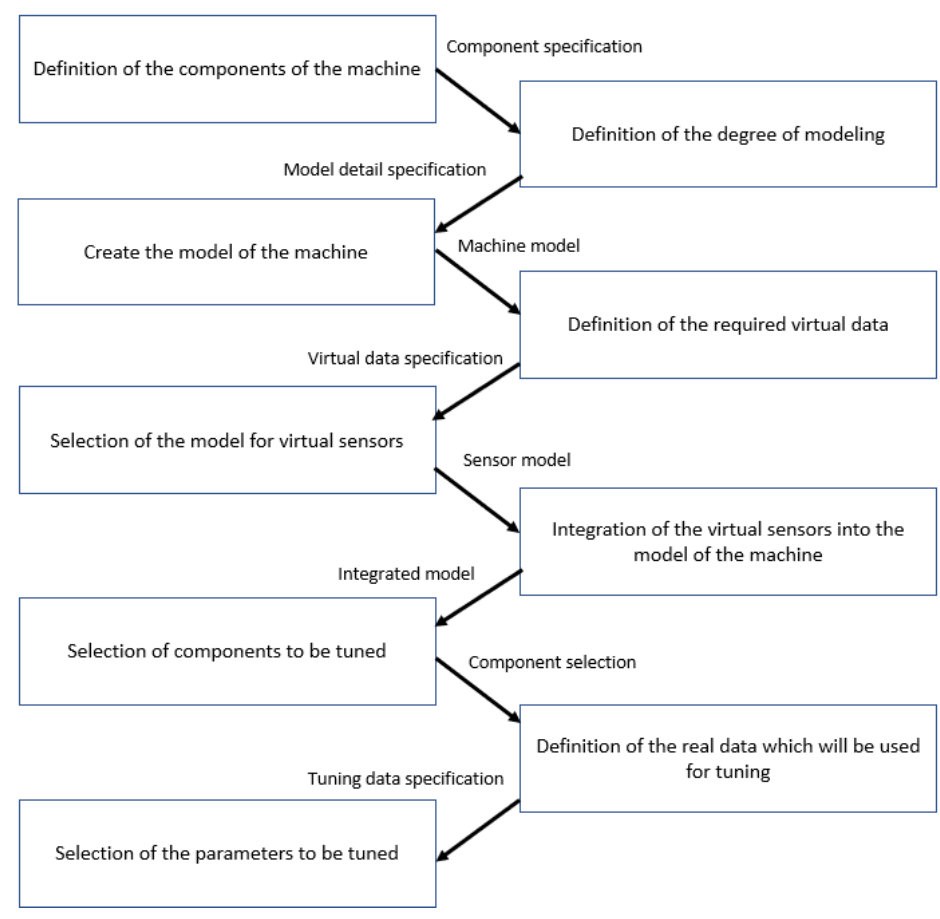
Figure 9. Sequence of domain-specific development sub-processes for predictive maintenance.